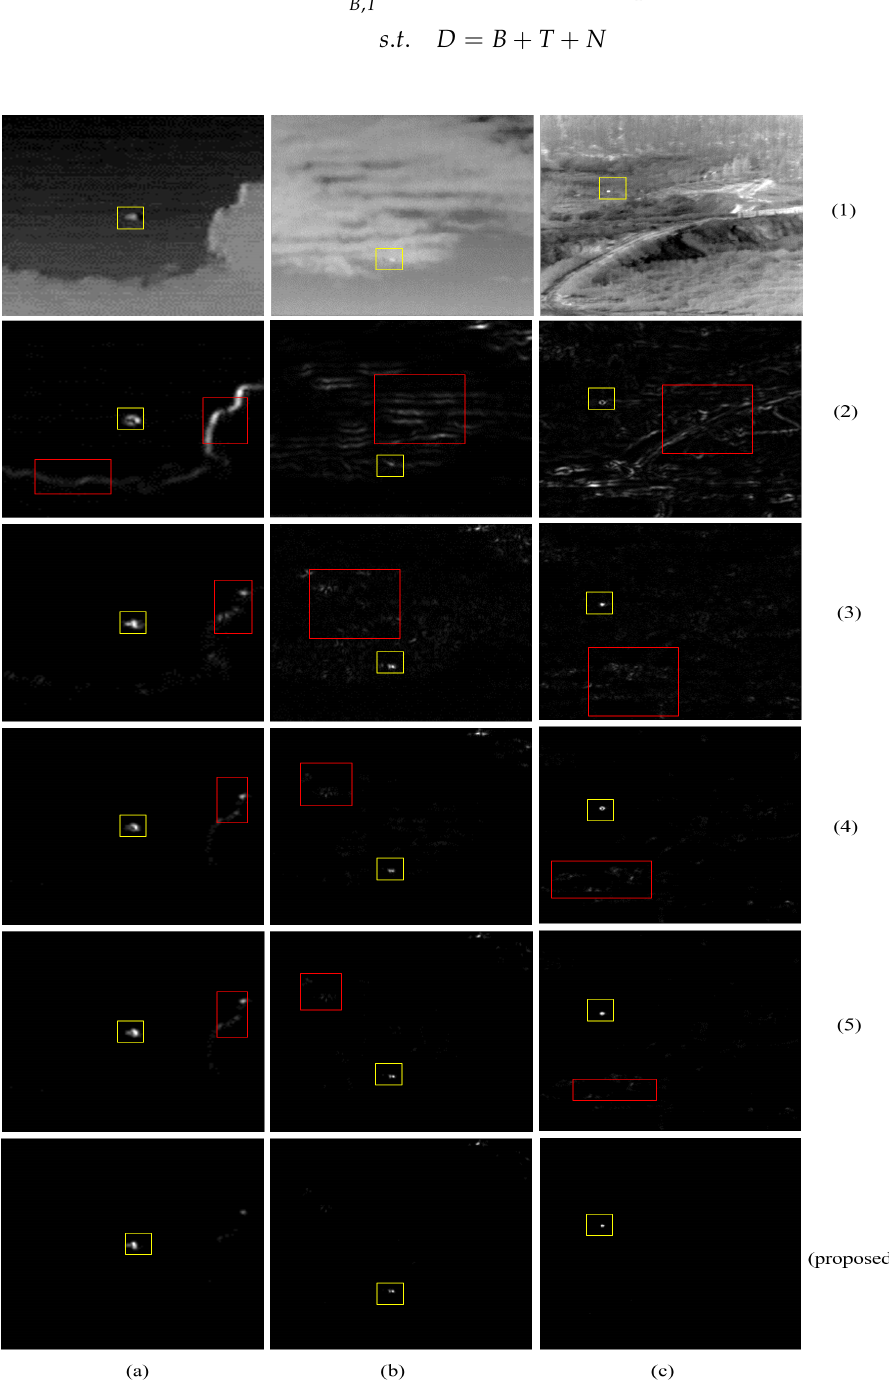
Figure 3. Different prior maps. Original images corresponding to the (1) row. Prior weight saliency maps calculated by Formula (11) corresponding to the (2) row. Prior weight saliency maps calculated by Formula (12) corresponding to the (3) row. Prior weight saliency maps calculated by Formula (13) corresponding to the (4) row. Prior weight saliency maps calculated by Formula (14) corresponding to the (5) row, and prior weight saliency maps of the proposed algorithm calculated by Formula (15). Columns ( a – c ) are the prior weights obtained by different calculation methods for the same